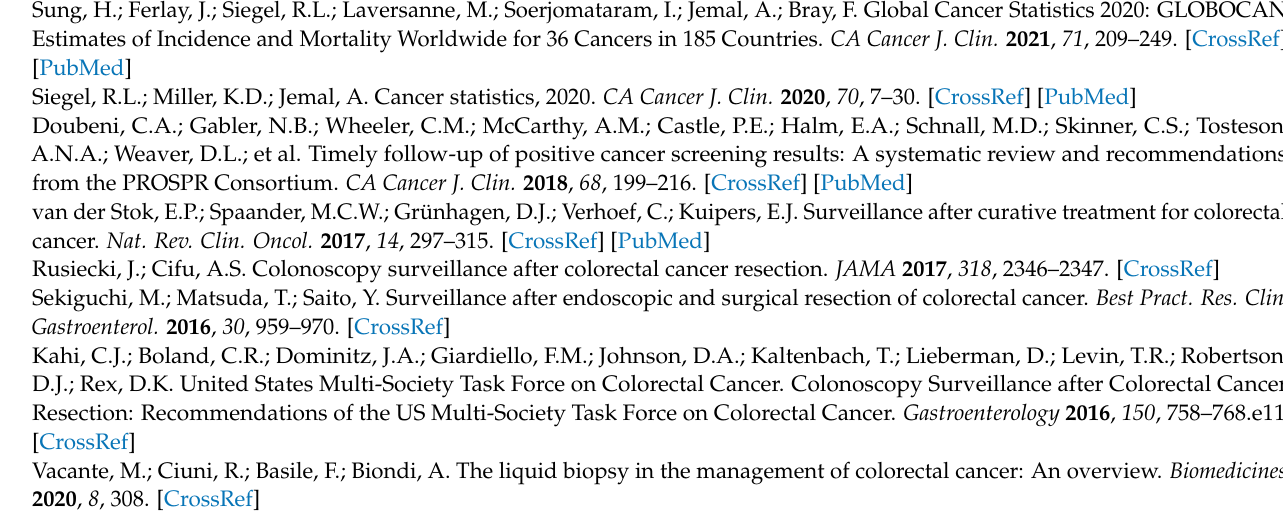
Figure S4: Analysis of the 14 target proteins in plasma EV samples from 80 healthy controls and 73 CRC patients; Table S1: Clinicopathological characteristics of the subjects from whom plasma samples were obtained and used in this study; Table S2A/B/C/D: List of proteins identified from the HT29/Colo205/SW480/SW620 cell line by 2D-LC-MS/MS; Table S3: List of 518 target membrane proteins and their cell compartment annotations; Table S4: Topological analysis of 518 target mem- brane proteins; Table S5: List of proteins identified by AIMS in plasma EV samples from HCs and CRC patients; Table S6: List of proteins in plasma EV samples from HCs and CRC patients quantified using iTRAQ; Table S7: List of tier 1, 2, and 3 target proteins; Table S8: AIMS results of 25 tier 1 target proteins from 5 HC and 6 CRC cases; Table S9: Summary of the precision and performance of the 14-plex LC-PIS-MS assay; Table S10: Concentrations and fold-changes of three target EV proteins, CD9, and CEA in HC and TNM stage I/II CRC plasma samples. File S1: Original